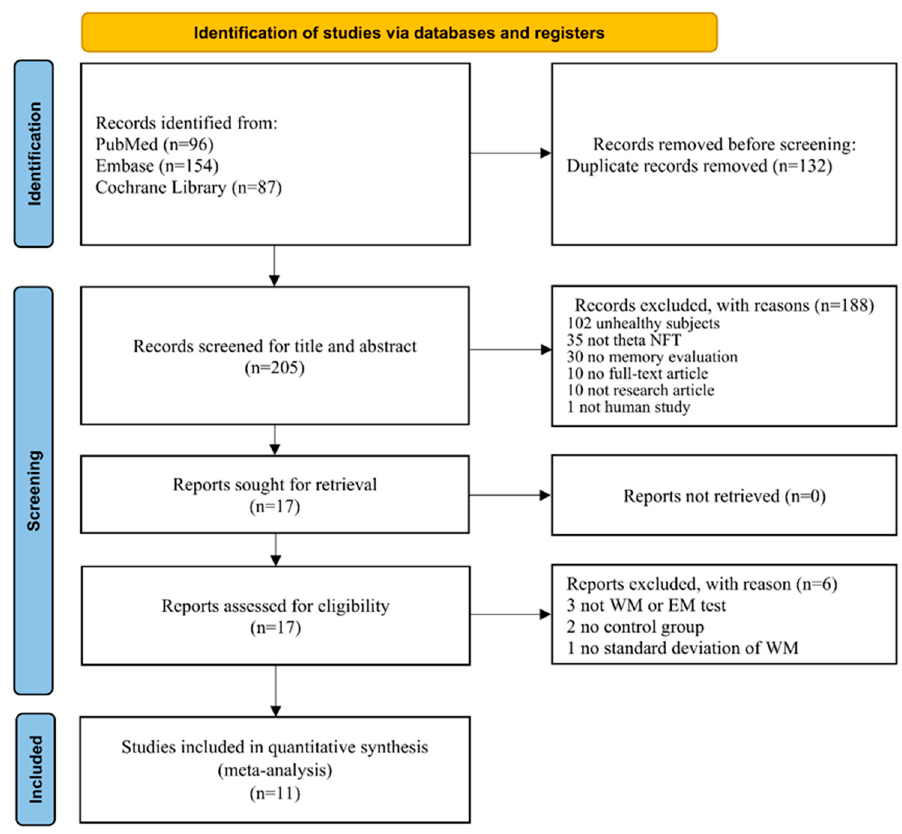
Figure 1. The Preferred Reporting Items for Systematic Reviews and Meta-Analyses (PRISMA) flowchart outlining the selection of studies included in the systematic review with meta-analysis.